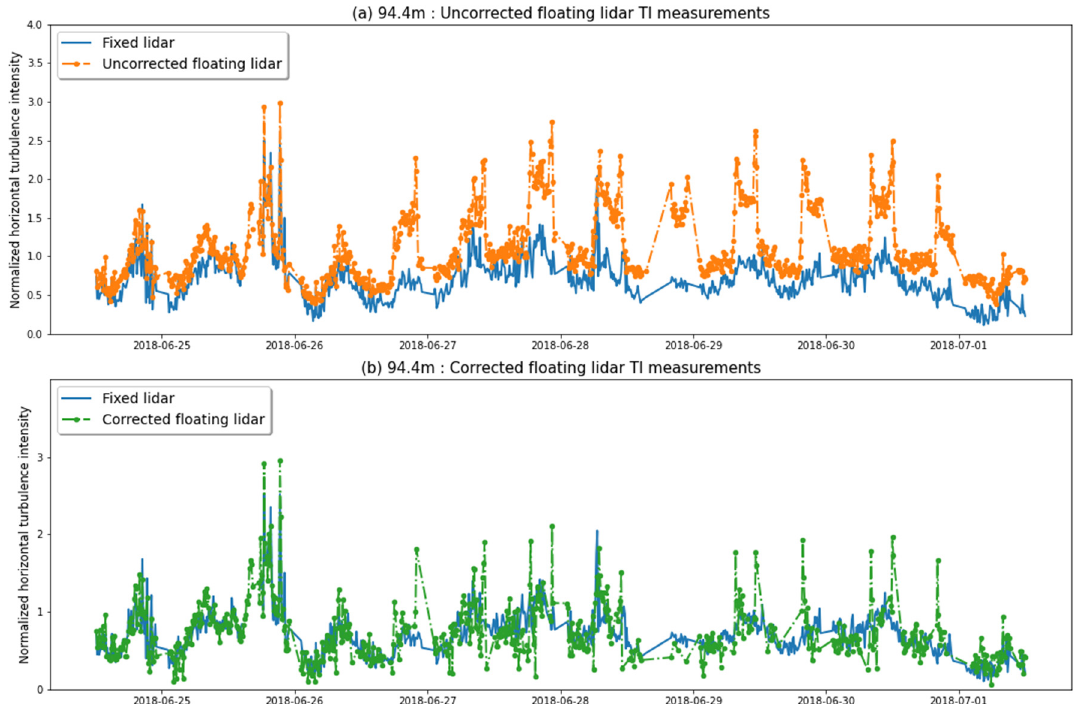
Figure 16. Effect of the model-based correction of the turbulence intensity measurement for the harshest week of the overall 13 (from 06/24/18 to 07/01/18). FLS measurements are compared with the fixed LIDAR measurements. All samples are normalized by the mean value from the fixed LIDAR. ( a ) Uncorrected floating LIDAR measurement. ( b ) Corrected measurement using the 10-min model-based correction presented in Section 3.1.